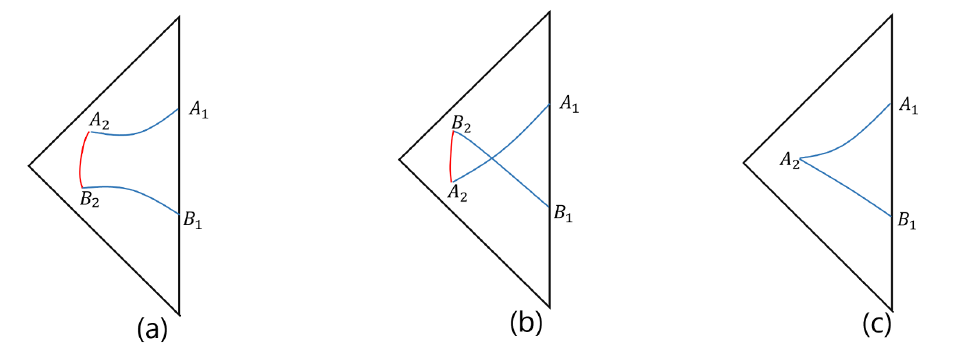
Figure 3 . There are three different possible configurations to connect the endpoints of time-like interval A by a few of